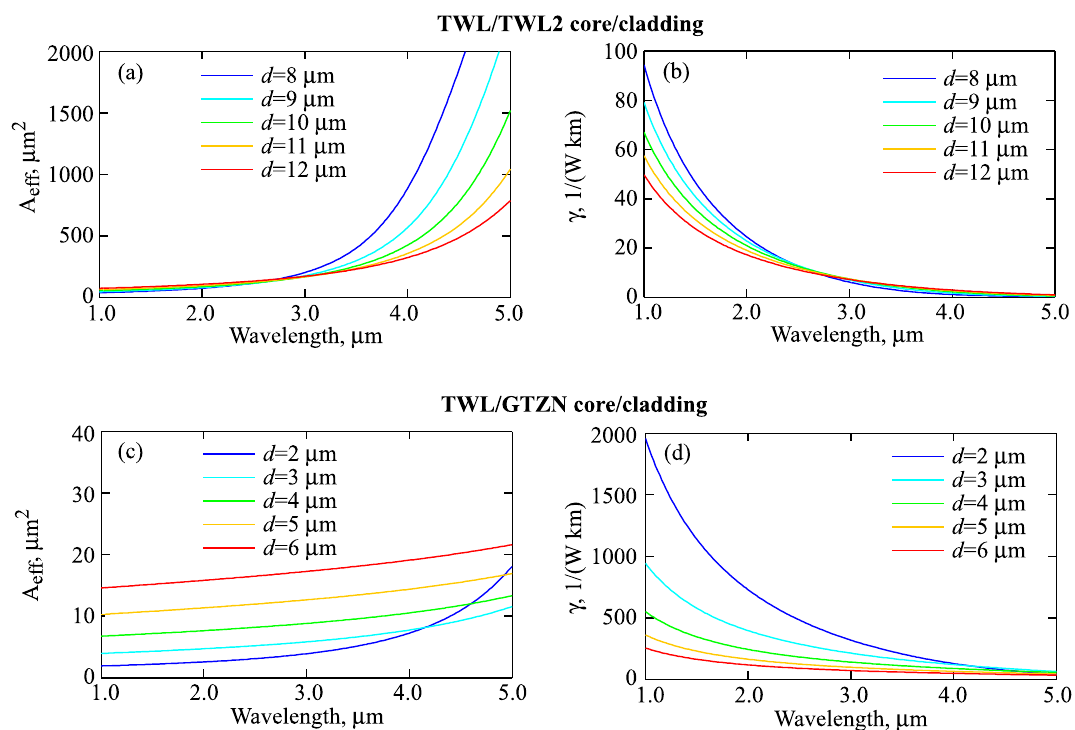
Figure 4. The calculated effective mode field areas A eff and nonlinear Kerr coefficients γ for one-core fibers with different core diameters for TWL/TWL2 core/cladding ( a , b ) and for TWL/GTZN core/cladding ( c , d ).